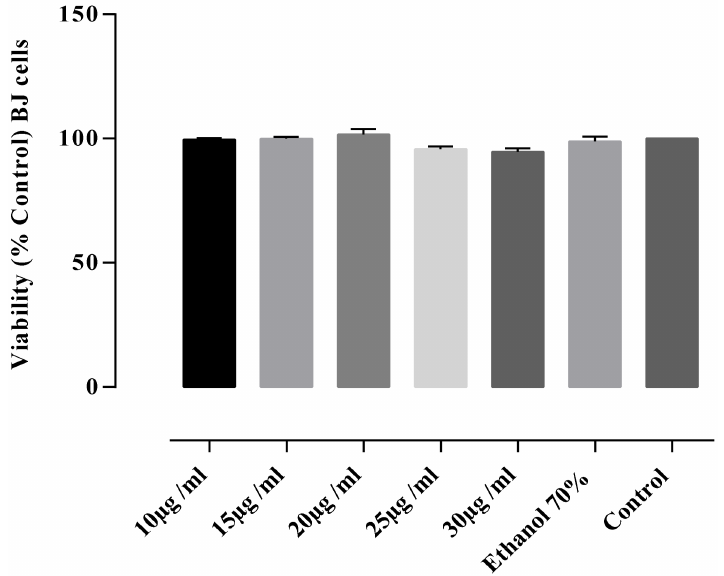
Figure 4. Cytotoxic activity assay results of F. schleicheri extract (FS3) on BJ cell line. Negative control—untreated cells. Internal control—cells treated with 70% ethanol solution. Values represent the mean ± SD of three independent